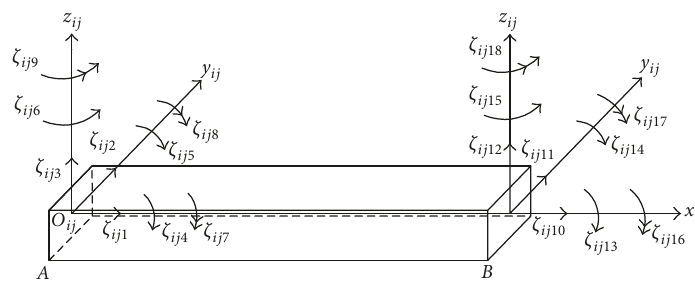
Figure 5: Space rectangular beam